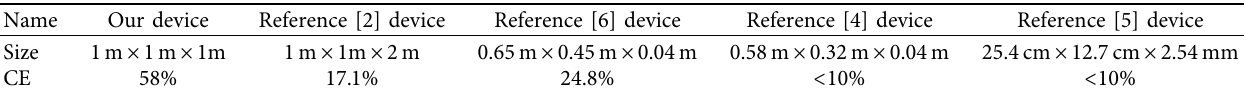
Table 1: Te comparison of parameters between this device and other